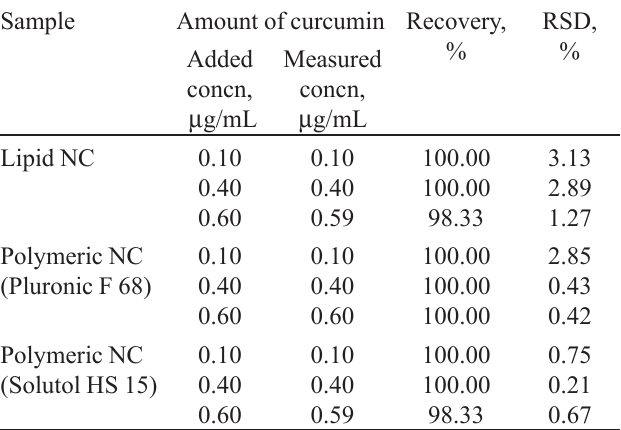
TABLE II - Recovery of curcumin standard solution added to nanocapsule suspension samples Sample